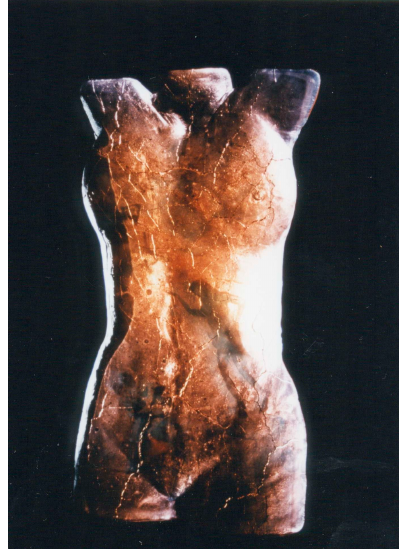
Figure 3. Goshka Bialek; Imagination I , 2001; cast uranium glass with an immersion of printings; 180 cm × 50 cm × 30 cm; photographed by Tim Adams, used by permission.